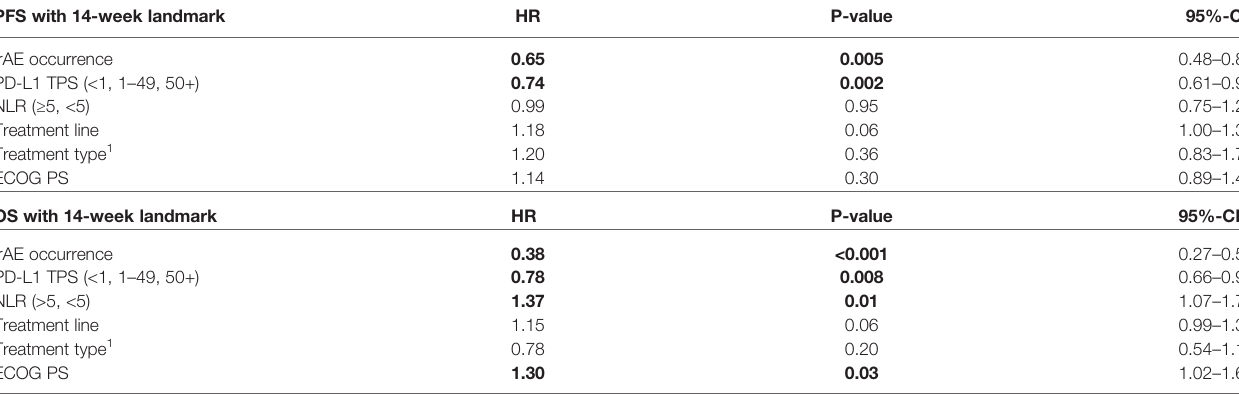
TABLE 4 | Multivariable analysis of progression-free and overall survival according to occurrence of irAE in NSCLC. PFS with 14-week